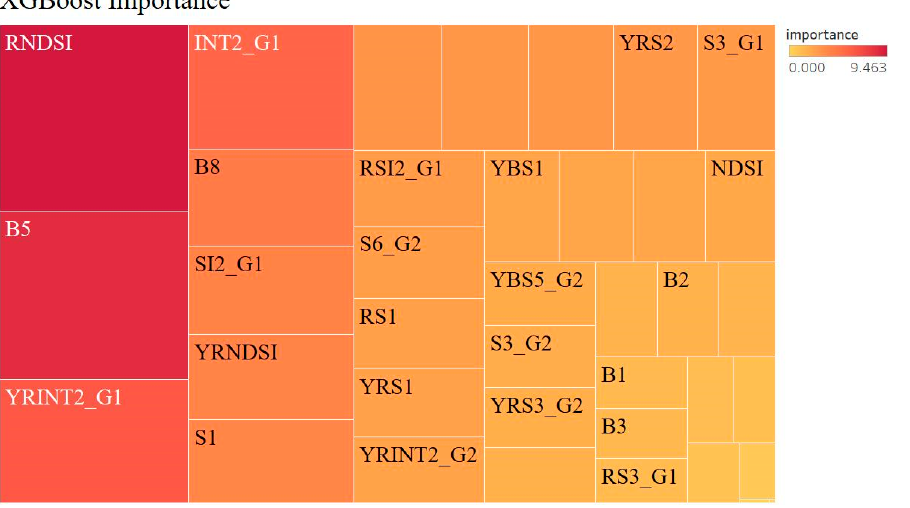
Figure 7. Extreme gradient boosting (XGBoost) algorithm to determine the importance of the existing salinity index and the new salinity index.